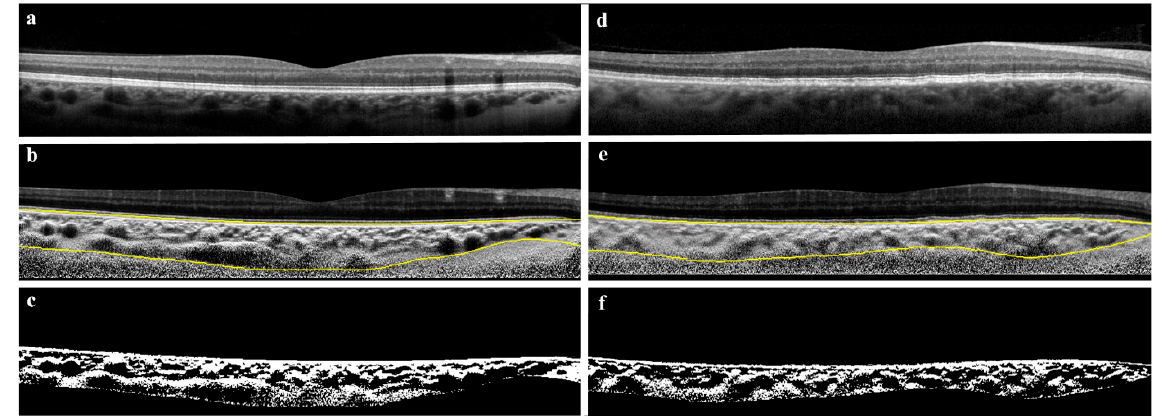
Figure 3. Choroidal vascularity index (CVI). CVI data was generated from OCT cross-sections ( a , d ) through automatic segmentation ( b , e ) and binarization ( c , f ). Pictured is a SLE patient without DLD ( left column ) and a SLE patient with DLD ( right column ).